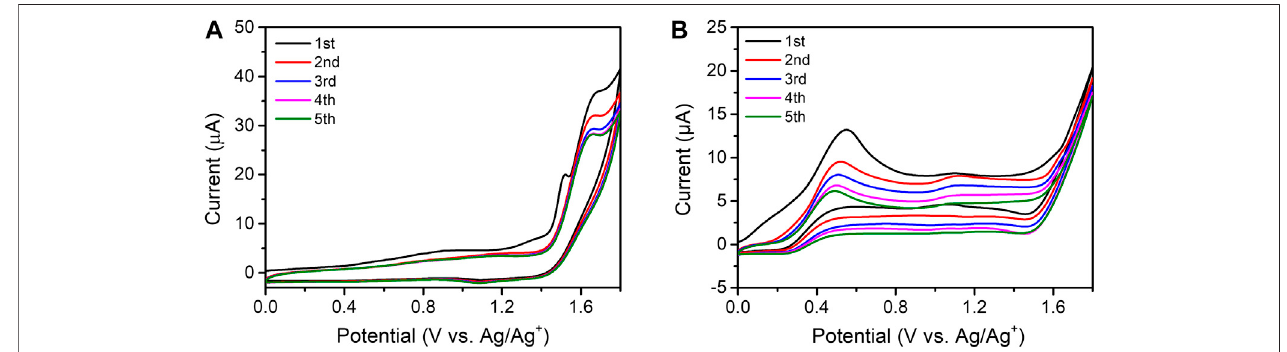
FIGURE4| Spectroelectrochemicalanalysisof (A) CsPbBr 3 and (B) CsPbI 3 withrespecttotheappliedpotential.Thepotentialwasincreasedfrom0.0to+1.4 Vin +0.2 V steps. The insets show magni fi ed views of the UV-Vis absorption spectra, which are highlighted in green. Kinetic trace of the absorption spectra of (C) CsPbBr 3 and (D) CsPBI 3 . The recorded spectroscopic traces correspond to the data of CsPbBr 3 and CsPBI 3 in (A) and (B) , respectively.